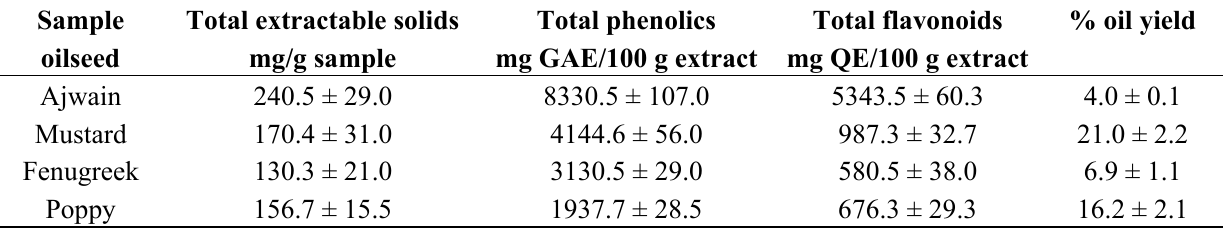
Table 1. Total extractable solids, total phenolics, flavonoids and % oil yield of the oilseeds. Sample